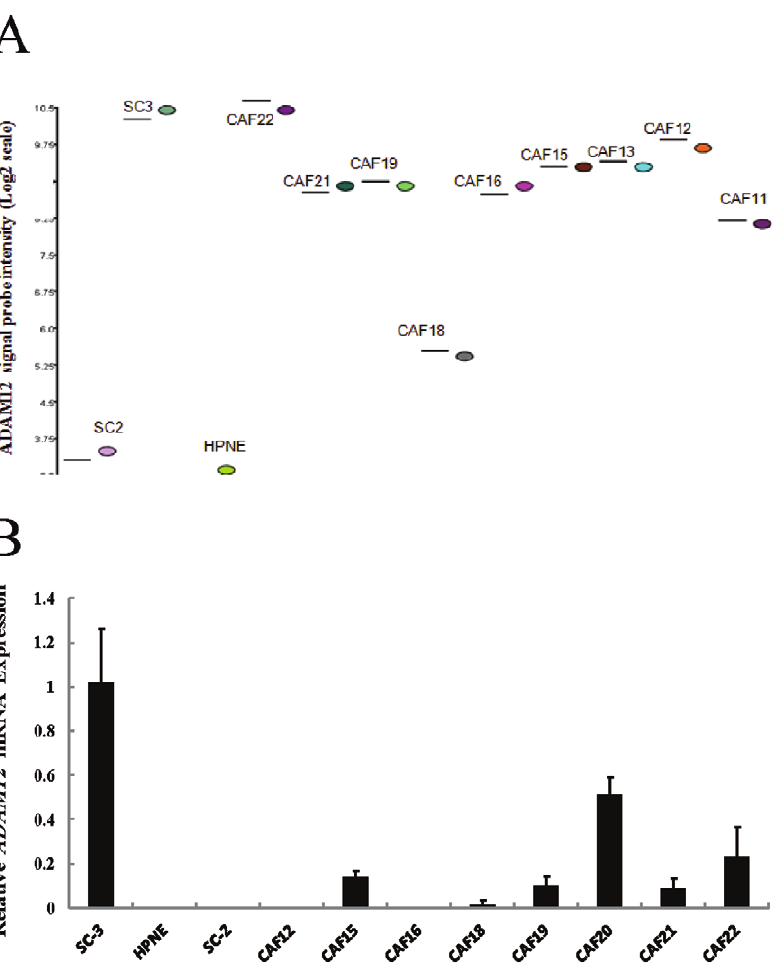
Figure 4. Analysis of ADAM12 mRNA expression in pancreatic CAFs and control fibroblasts. (A) Affymetrix exon array analysis of ADAM12 mRNA expression in pancreatic CAFs and control fibroblasts. (B) Quantitative RT-PCR analysis of ADAM12 mRNA expression in pancreatic CAFs and control fibroblasts after normalization to GAPDH levels. Each assay was performed in triplicate. Data are means of three independent experiments; bars are SD values.